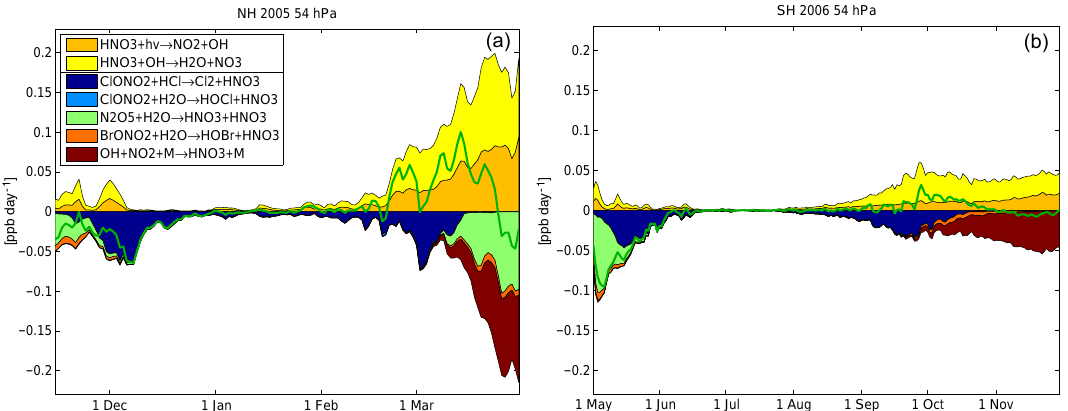
Figure 4. Vortex-averaged chemical reaction rates of reactions changing extended NO x (NO + NO 2 + NO 3 + 2N 2 O 5 + ClONO 2 + BrONO 2 + HO 2 NO 2 ) for the Arctic winter 2004–2005 (a) and the Antarctic winter 2006 (b) at 54hPa. Production reactions are shown as positive and are separated by a line in the legend from the loss reactions, which are shown as negative. The net change of extended NO x is shown as a green line. Reactions with rates which cannot be distinguished from the zero line at plot resolution are not shown.